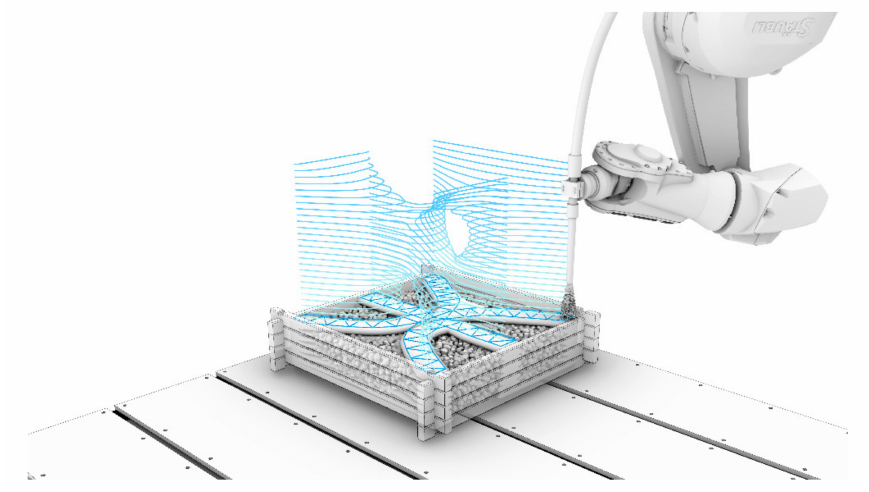
Figure 1. Basic concept of Large Particle 3D Concrete Printing (LP3DCP): (1) a layer of large particles, i.e., coarse aggregates, is distributed; (2) fine grain concrete is sprayed in the voids; (3) this step is repeated until the desired geometry is produced (copyrighted by the Institute for Structural Design, TU